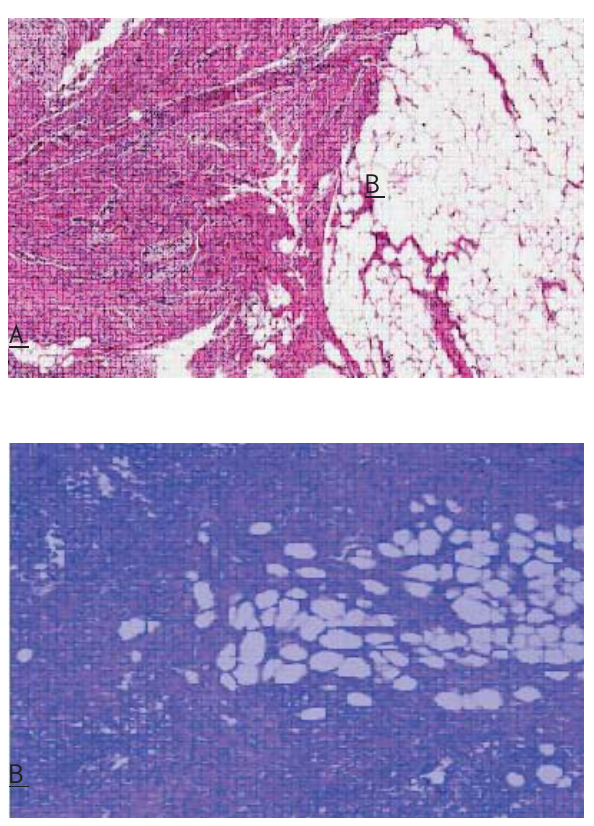
Figure 2. Cut section of the mass showing multipleseptations with blood vessels and clots inside Microscopic examination showed disorganized pattern of tissue consisting of smooth muscles, fi brous tissues, adipose tissues and blood vessels.(Figure3).